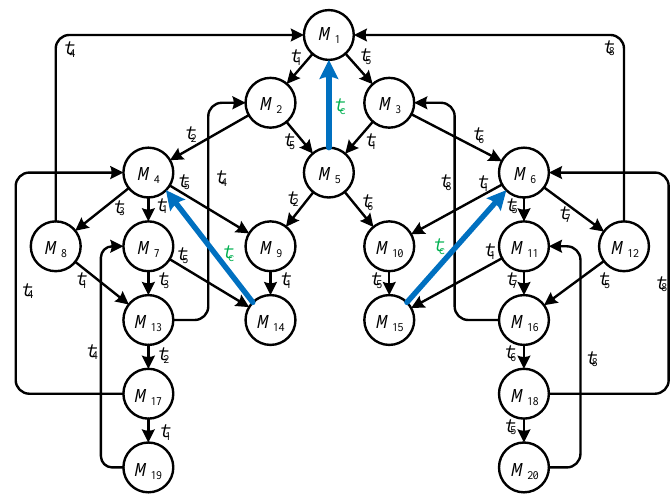
Figure 5. The real maximally permissive reachability graph of Figure 4.